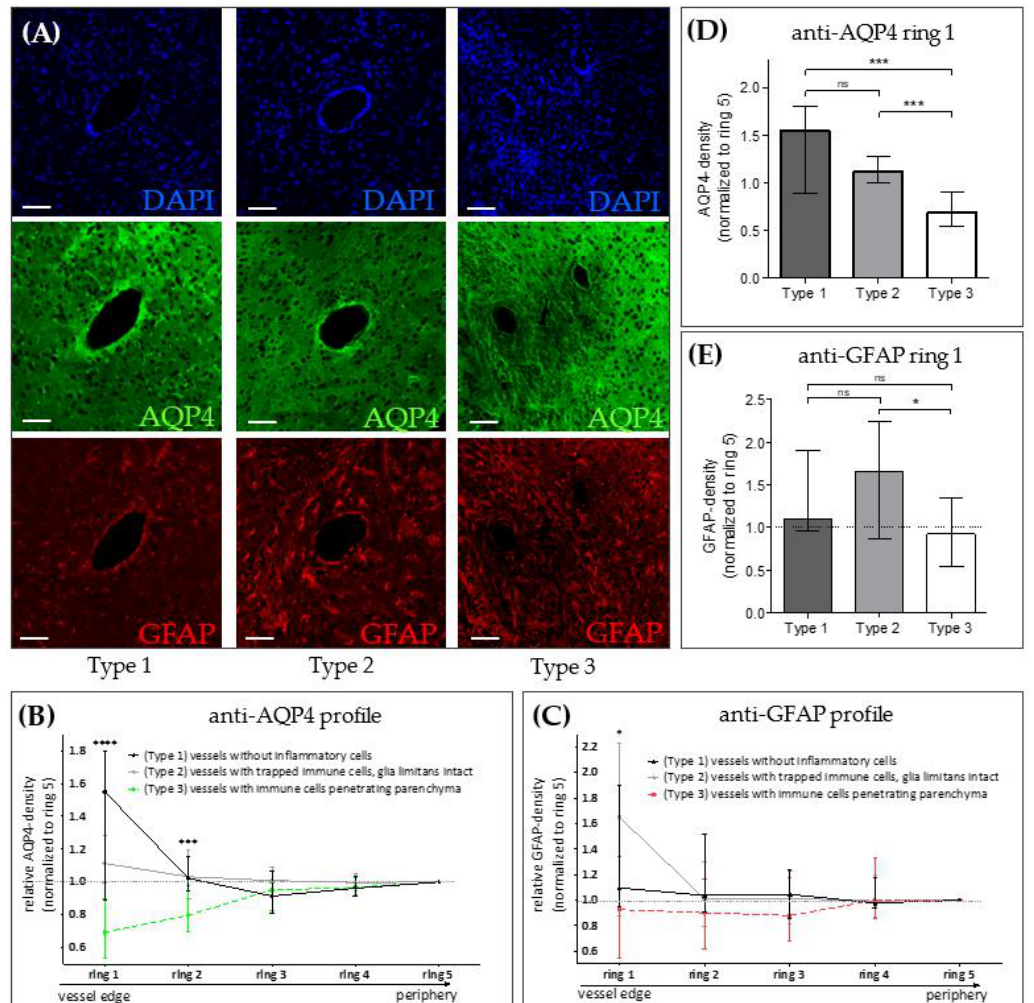
Figure 3. AQP4 expression in the Cuprizone/EAE model. ( A ) Representative images of forebrain vessels in Cuprizone/EAE mice, shown in three spectral layers (triple-immunofluorescence): DAPI (blue, upper row), AQP4 (green, middle row), GFAP (red, bottom row). Left column: Type 1 vessels (no inflammatory cells in the perivascular space). Middle column: Type 2 vessels (immune cells trapped within an intact glia limitans). Right column: Type 3 vessels (immune cells penetrating the brain parenchyma). Scales: 30 µm. ( B , C ) Semi-automated evaluation of perivascular optical densities in AQP4 and GFAP spectral layers in 5 concentric rings around the vessel (see Appendix Figure A1 for details of the applied evaluation method). Ring 1 represents the vessel’s edge, ring 5 its outermost peripheral part. ( D , E ) Comparison of anti-AQP4 and anti-GFAP optical densities in ring 1. Data is shown as median + IQR and was tested via Kruskal-Wallis test ( B , C ) followed by Dunn’s post-hoc test for ring 1 ( D , E ); type 1 n = 9; type 2 n = 24, type 3 n = 22; ns = not significant, * = p < 0.05, *** = p < 0.001, **** = p < 0.0001.